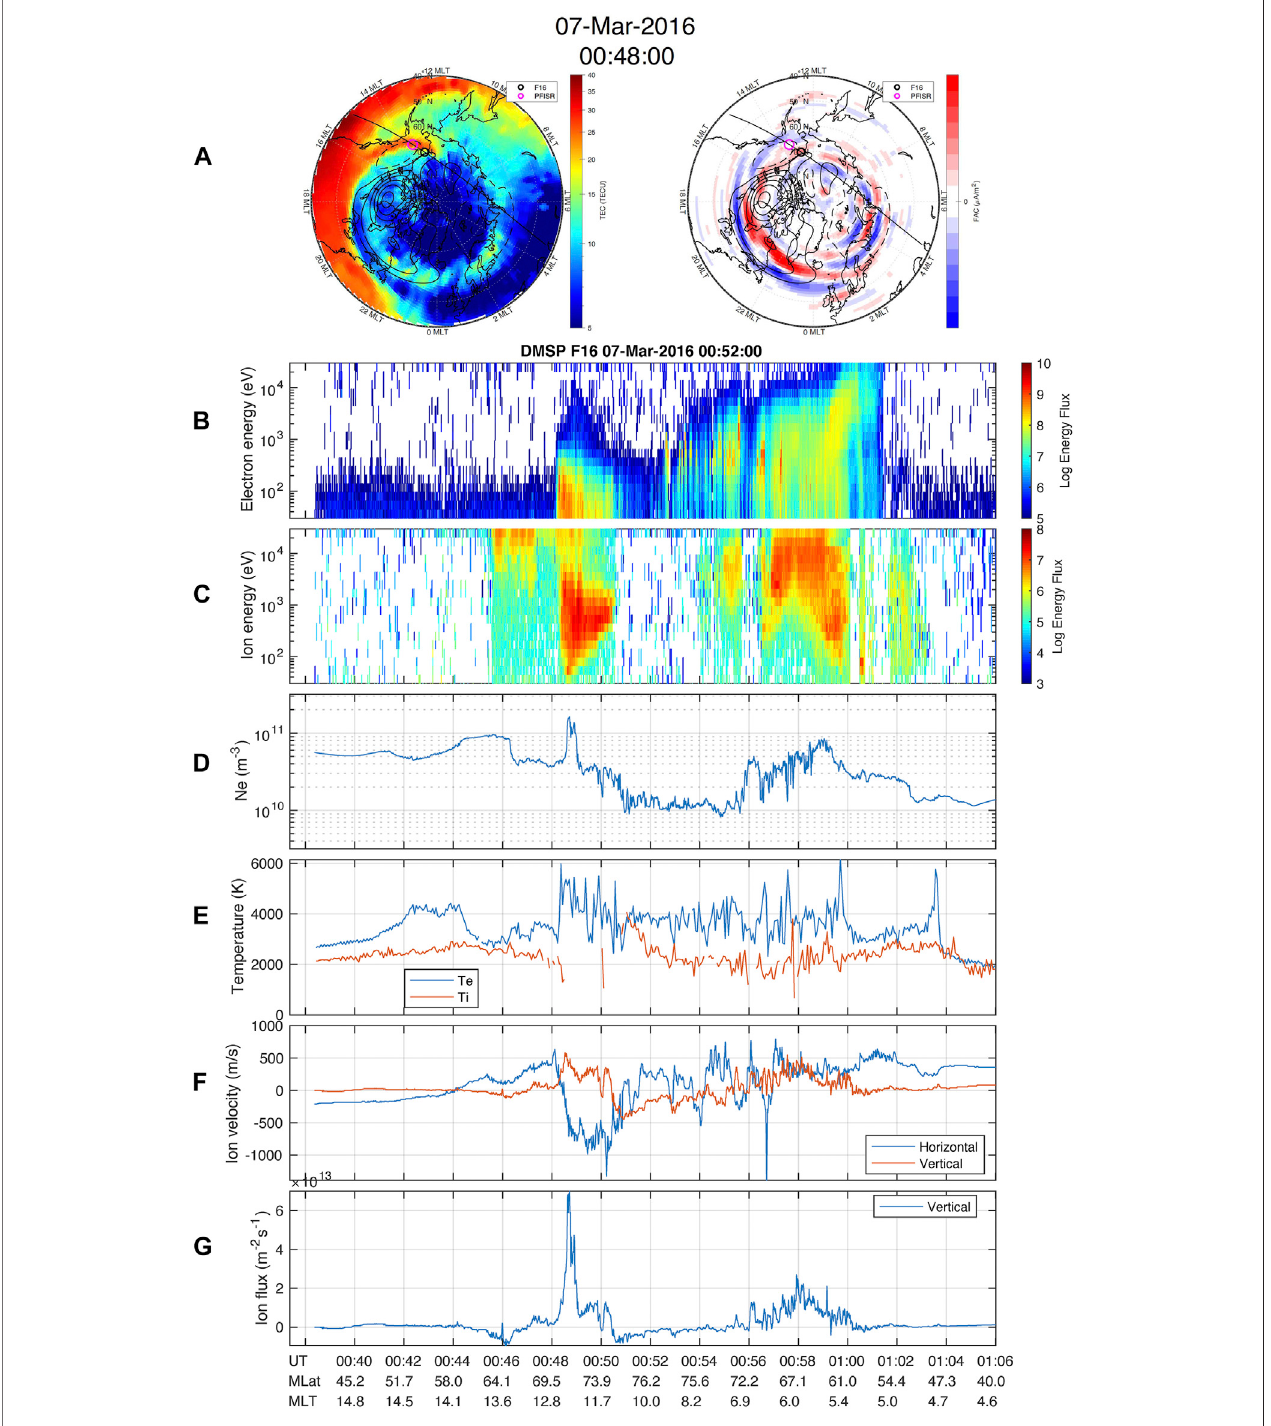
FIGURE 11 | The same format as Figure 9 but the large up fl ow fl uxes were associated with the SED plume during its decaying phase.